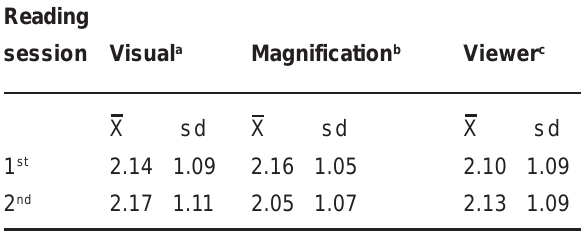
measurement sessions, viewing methods, or interaction between observation session and method (p>0.05). The intra-observer measurement error was 0.02 mm for both the Visual and the Magnification methods and 0.01 mm for the Viewer. TABLE 1- Mean ( X ) and standard deviation (sd) of the measurements between endodontic file and radiographic apex for two reading sessions and three viewing conditions